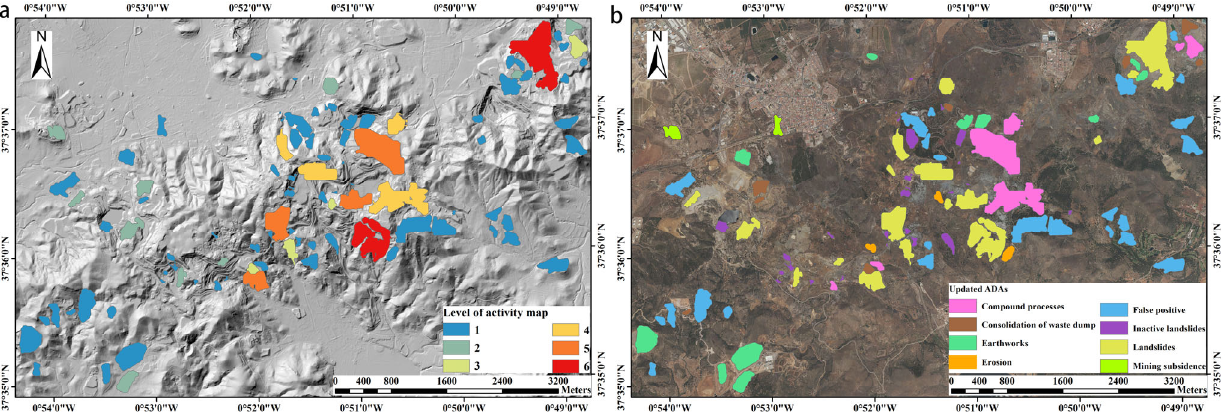
Figure 6. ( a ) Level of activity map of the updated inventory map. ( b ) Classification of the ADA of the updated inventory map according to the underlying deformation process.